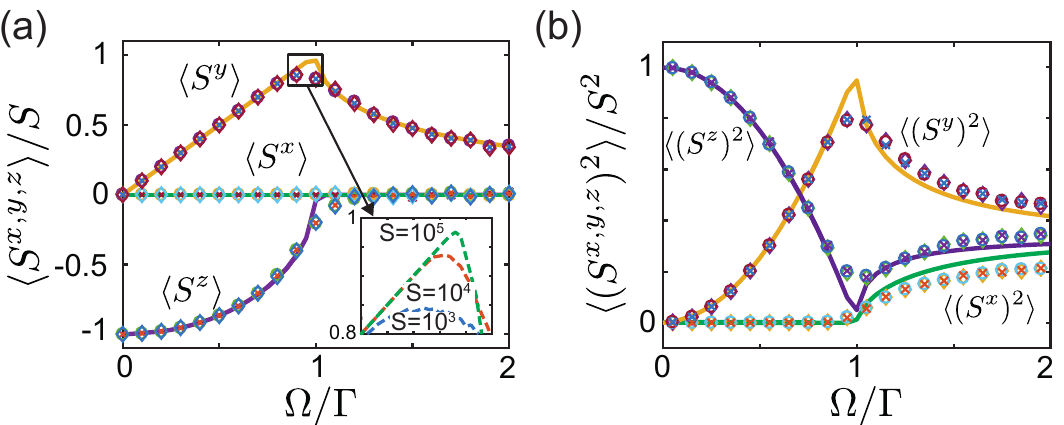
Figure 4: Simulation of the steady state of a driven spin system described by Eq. (29). The two plots show (a) the mean values and (b) the fluctuations of the three com- ponents of a spin with S = 1000. The solid lines are obtained from the exact so- lution for the steady state of this system [ 17, 35, 37 ] , while the crosses, diamonds and circles are obtained from a stochastic sampling of the P -, the Q - and the Wigner- distribution. The inset in (a) shows the simulations of the Wigner distribution for even larger spin numbers S around the transition point Ω / Γ = 1. The steady state was obtained by time averaging after t = 40 Γ − 1 for another period of ∆ t = 10 Γ − 1 = and for n traj